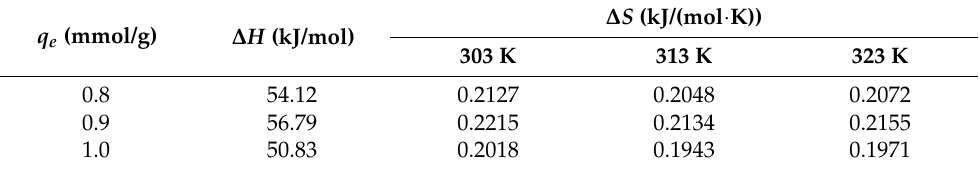
Table 3. Thermodynamic parameters for copper ion adsorption on the prepared hydrogel.